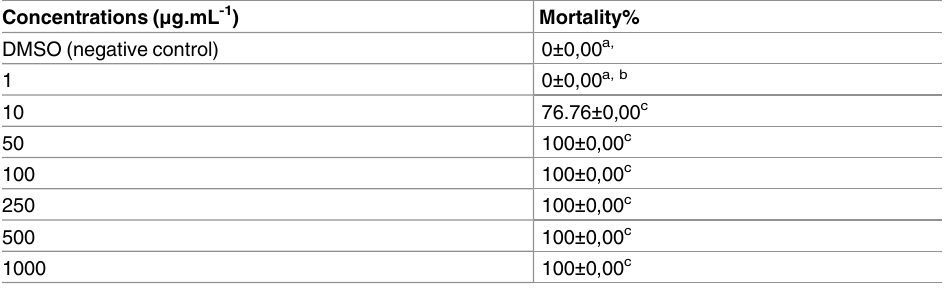
Table 3. Essential oil toxicity of Aeollanthus suaveolens front of the larvae of A . salina . Concentrations ( μ g.mL -1 )